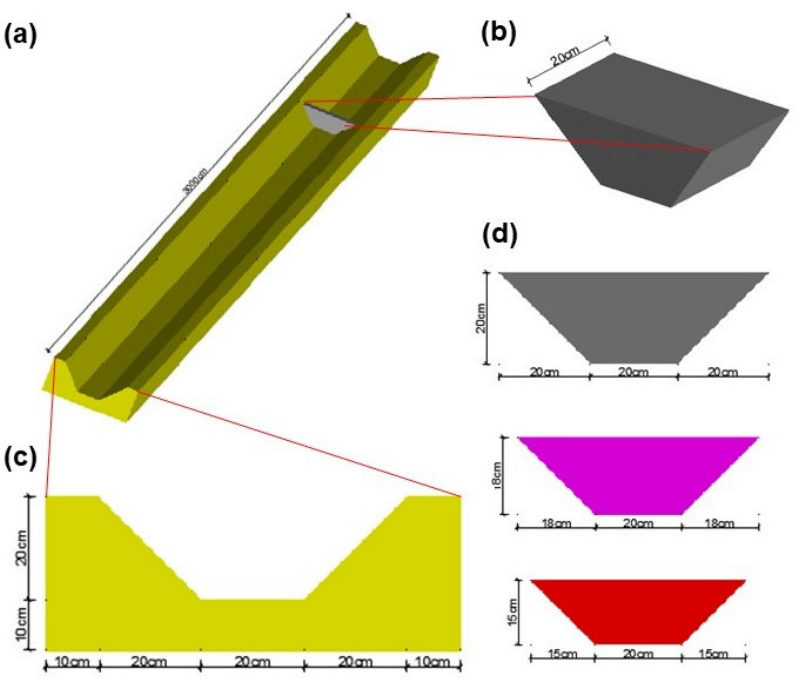
Figure 2. General view of the furrow and plug for the simulated furrow irrigation scenario. ( a ) Simulated furrow. ( b ) Plug. ( c ) Cross-sectional size of furrow. ( d ) Cross-sectional size of plug.